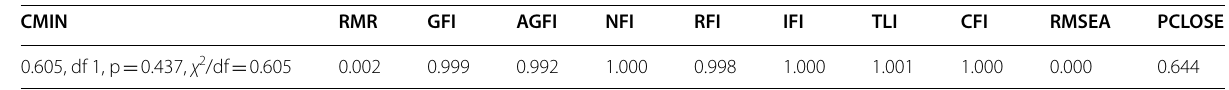
Table 4 Model fit indices (n